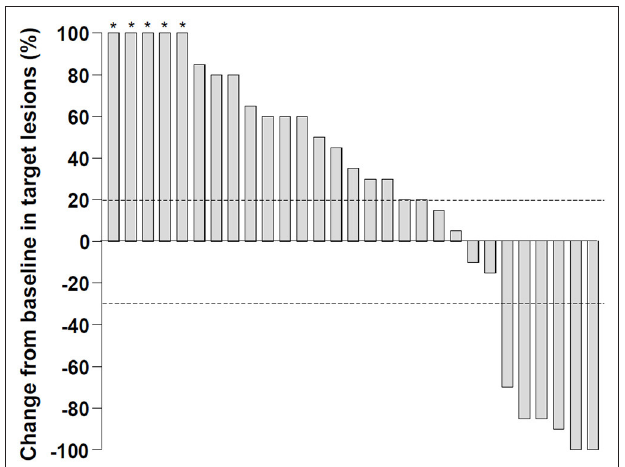
FIGURE 1 | Changes in target lesions from the baseline after nivolumab monotherapy. Dashed lines represent a 20% increase or a 30% reduction. The percentage changes more than 100% were truncated to 100% (asterisks)